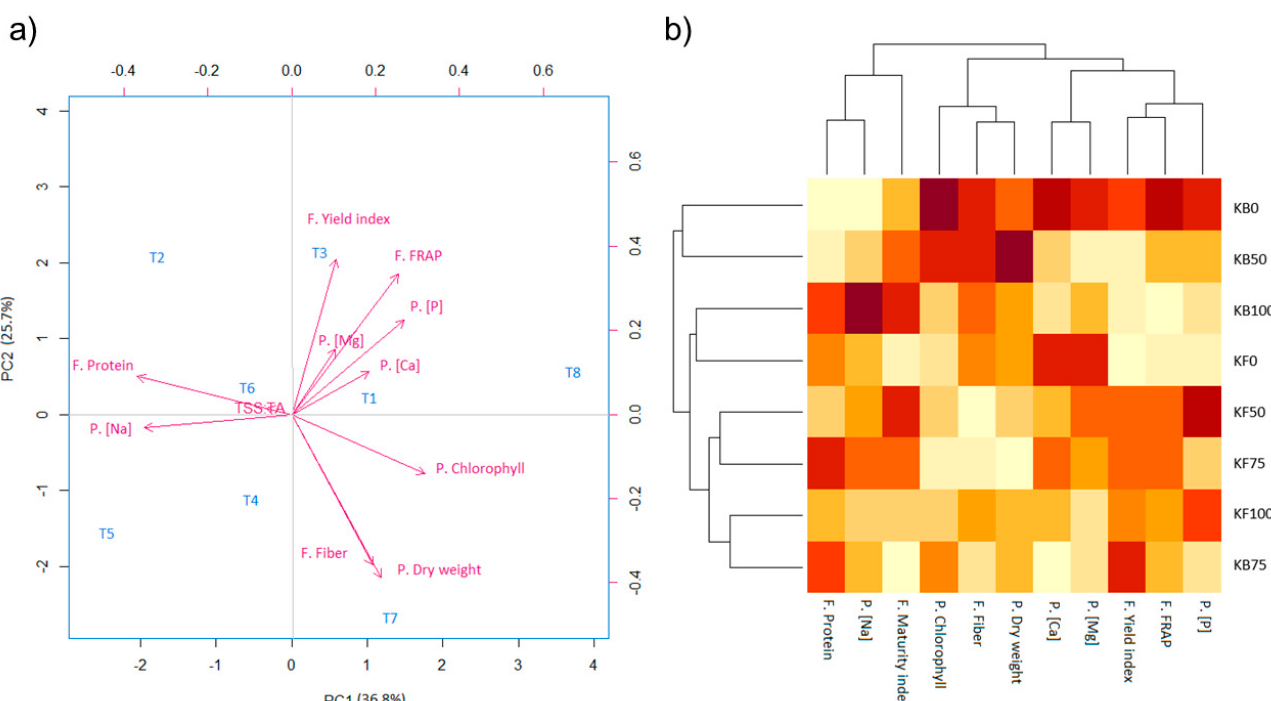
Figure 2. Multivariate analysis for the relevant parameters of tomatillo plants and fruits ( Physalis ixocarpa Brot. cv. “cáscara morada”) in the evaluation of the biofertilizing effect of Acinetobacter calcoaceticus UTMR2 at different doses of potassium. P: plant parameter; F: fruit parameter. T#: treatments according to the general experimental design; KF#: treatments with chemical fertilization only; KB#: treatments with chemical fertilization and biofertilization; #: potassium fertilization dose (%) based on the recommended dose for tomatillo cultivation [20]. ( a ) Principal component analysis (PCA biplot); ( b ) heatmap visualization plot.